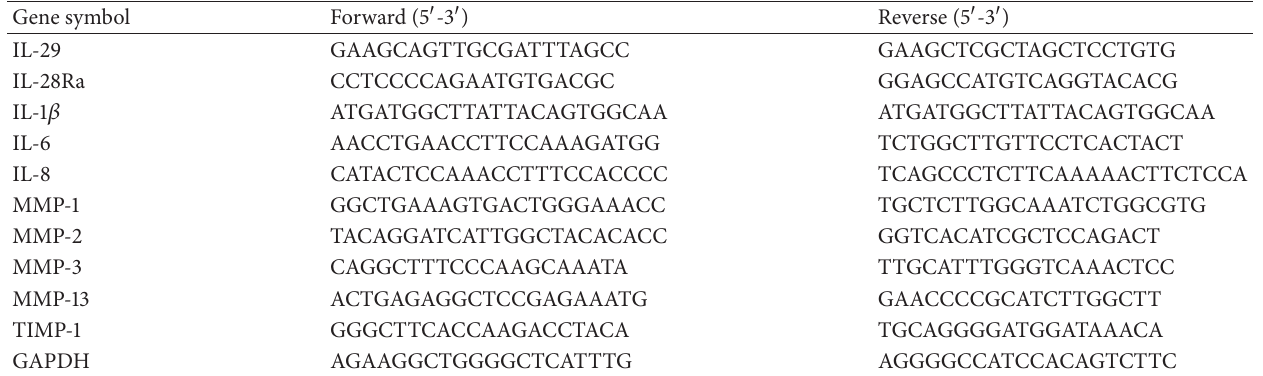
Table 3: Human primers used for real-time quantitative